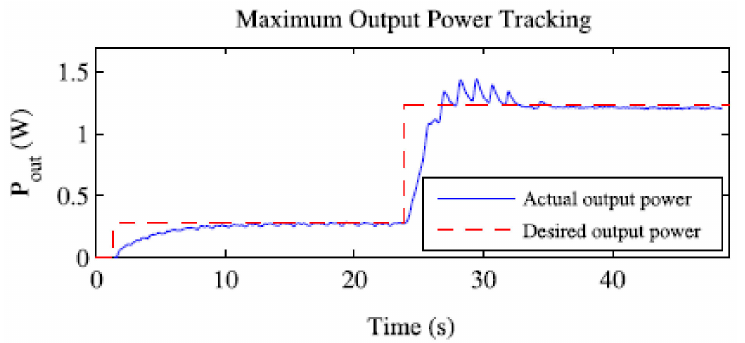
Figure 31. Output power for the converter “Adapted with permission from